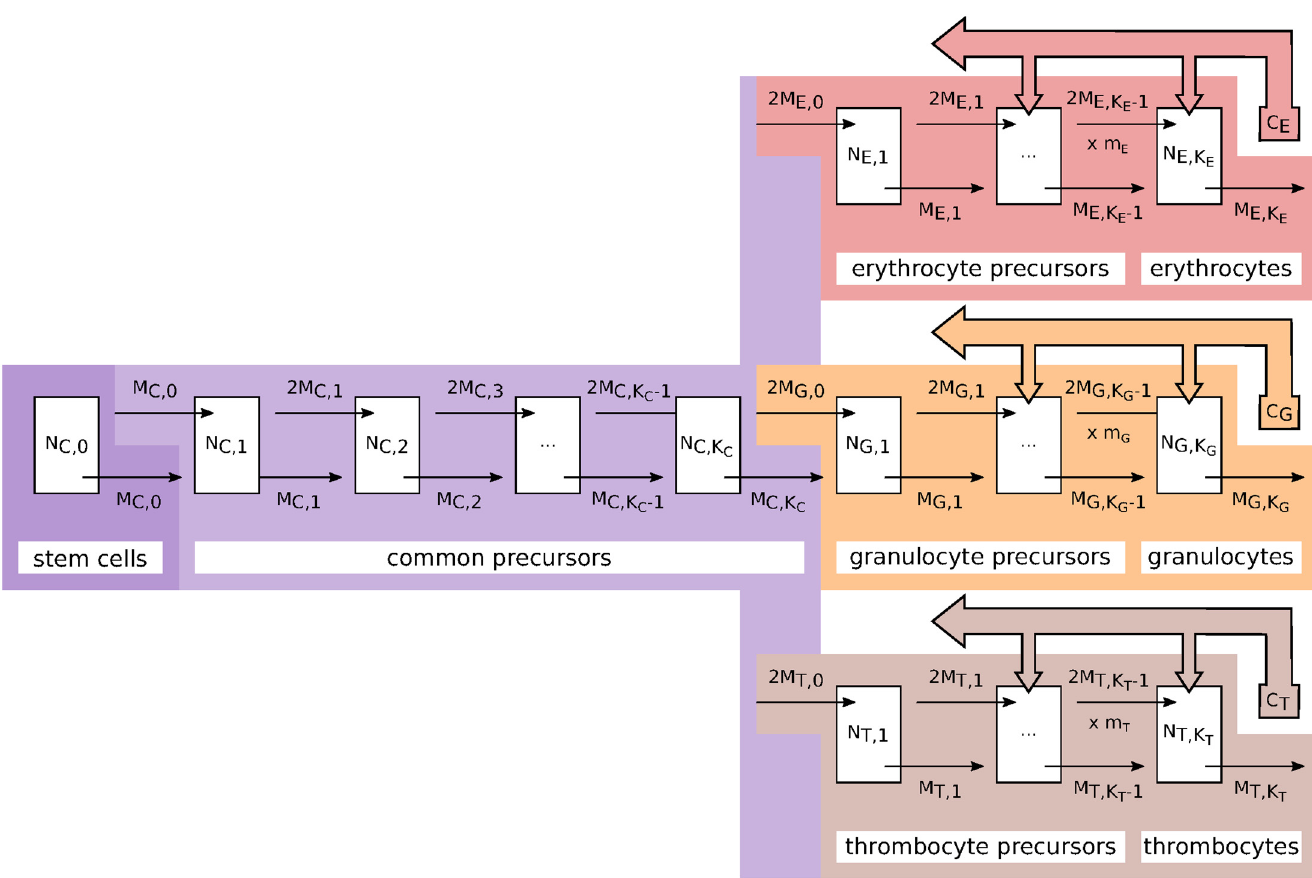
Fig 1. Illustration of the model’s compartments. The model consists of K C + 1 compartments for the common precursors. The zeroth compartment is the stem cell compartment. The erythrocyte lineage has K compartments, and the granulocyte and thrombocyte lineages have K E of cells in each compartment is given by N and the outflow of each compartment by M with the respective indices. The cells at the final stage (on the very right) model the mature blood cells in the blood stream. Deviations of the respective blood counts from their normal range result in lineage specific growth factors ( c E , c G , c T ) that feed back to all stages and increase their outflow.